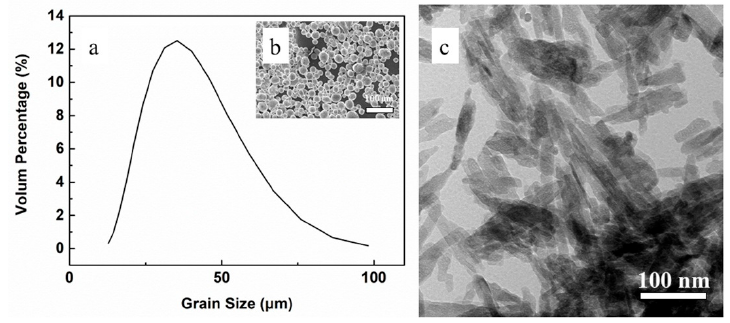
Figure 4. ( a ) Particle size distribution and ( b ) SEM (Scanning Electron Microscopy) image of 316L stainless steel powder, ( c ) TEM (Transmission Electron Microscope) morphology of the nano-hydroxyapatite powders. Metals 2018 , 8 , x FOR PEER REVIEW